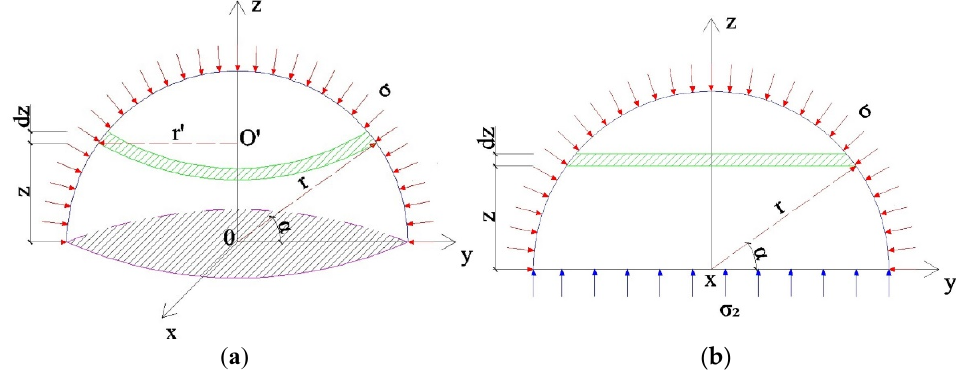
14 of 19 Figure 16. Space micro unit of the hydration product. O is the central point of the hydration prod- uct. r is the radius of the spherical hydration product. a is space micro unit length size. The volume ratio of hydration products to microscopic space units is 3